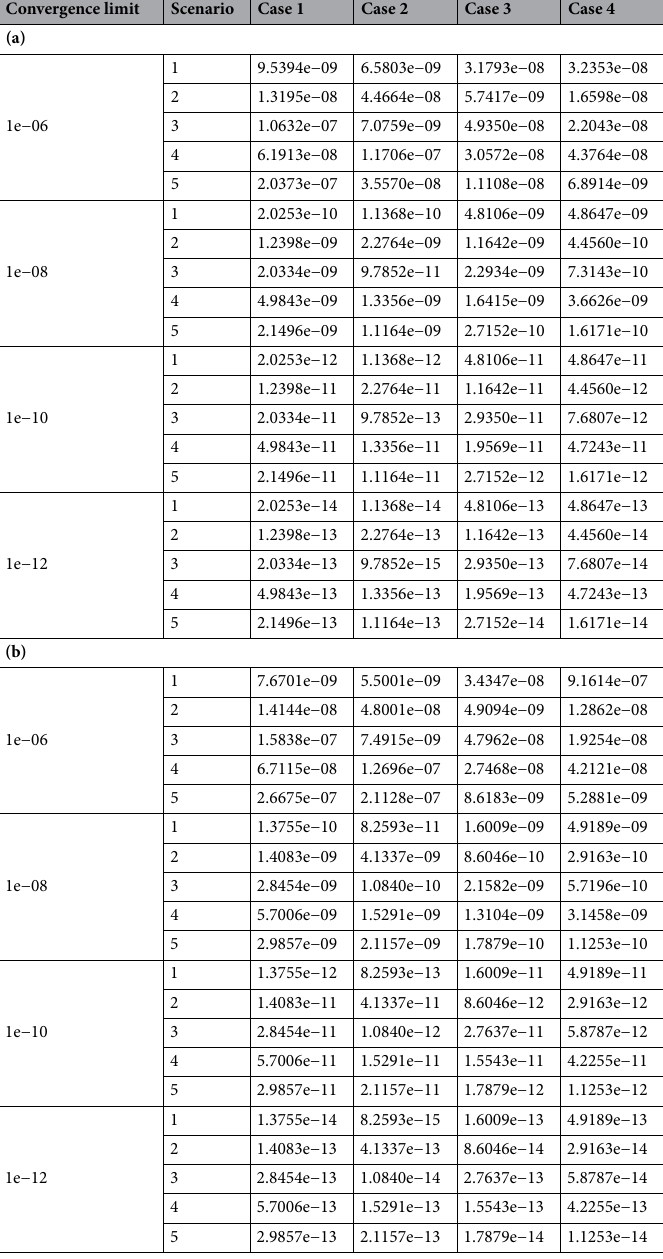
Table 3. Maximum Residual during different scenario and cases for (a) Copper nanoparticles, (b) Silver